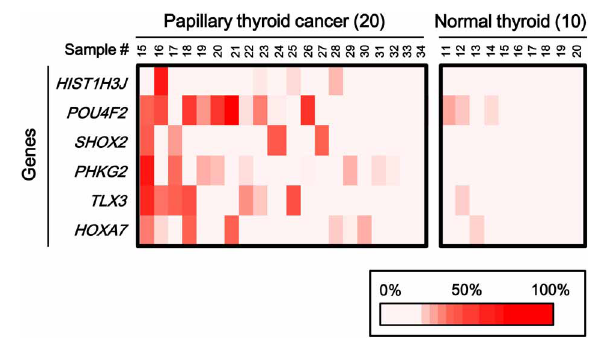
FIGURE 6 | Aberrant methylation of HOXA7 , POU4F2 , HIST1H3J , TLX3 , PHKG2 , SHOX2 genes in additional samples: 20 cancer samples and 10 normal ones. Methylation status of the six genes was confirmed by pyrosequencing. Bottom, color scale with known methylation degrees (0–100%).